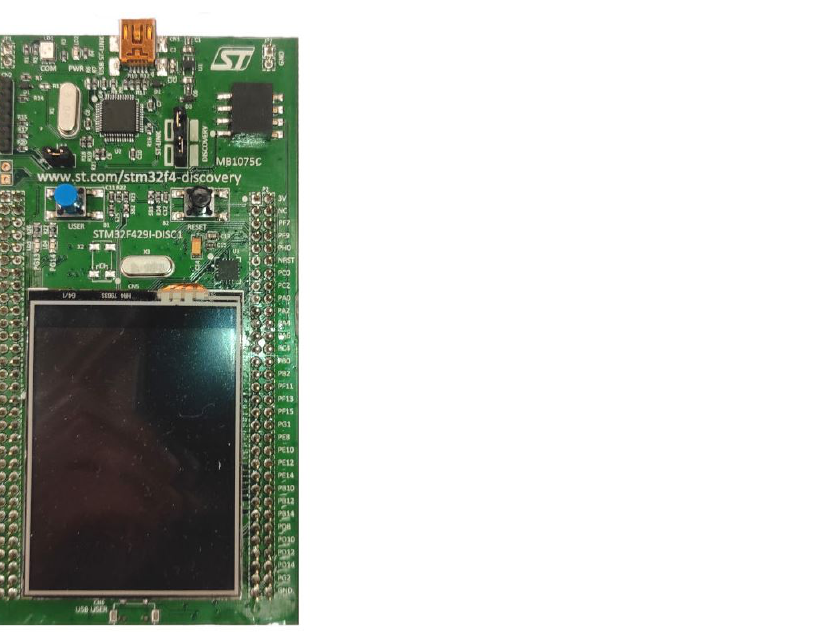
Figure 5. Photograph of the STM32F429I-DISC1 development board.